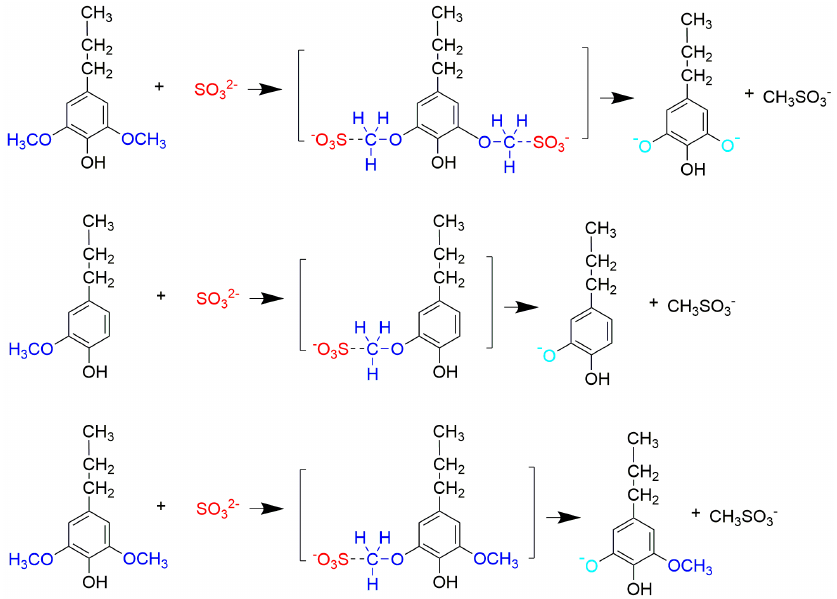
Figure 2. Reaction mechanism of lignin demethylation under mild condition .